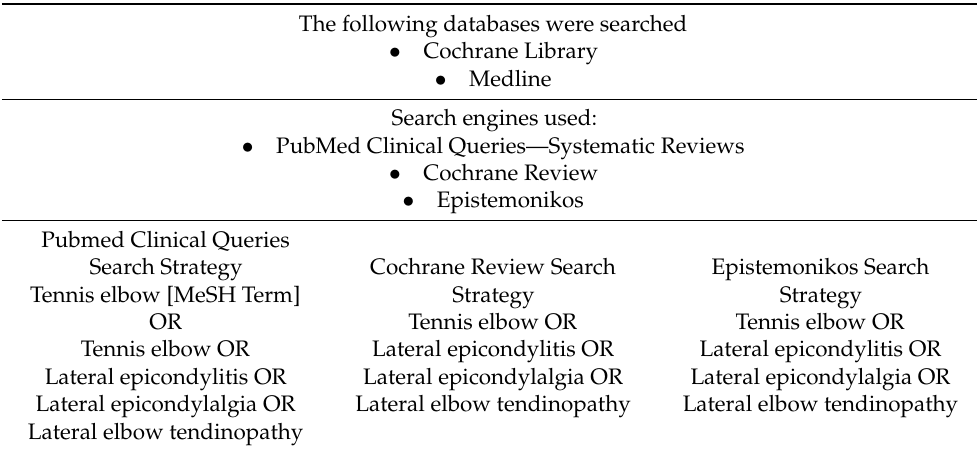
Table A1. Literature search